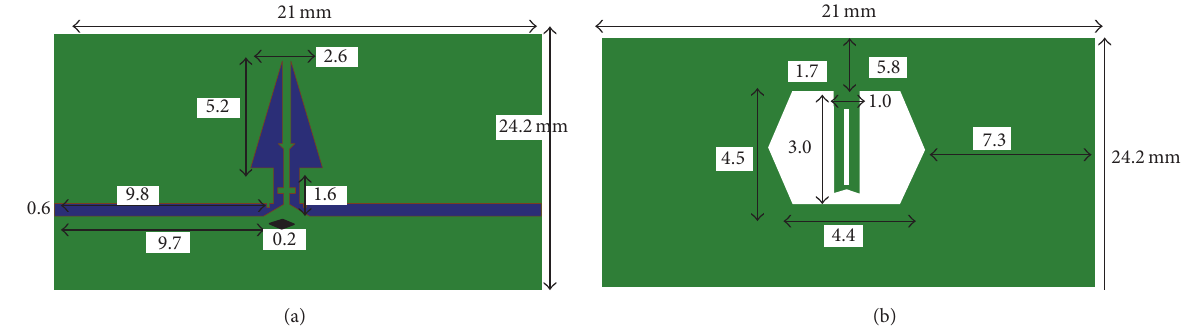
Figure 22: Schematic of UWB BPF [65]. (a) Top view. (b) Bottom